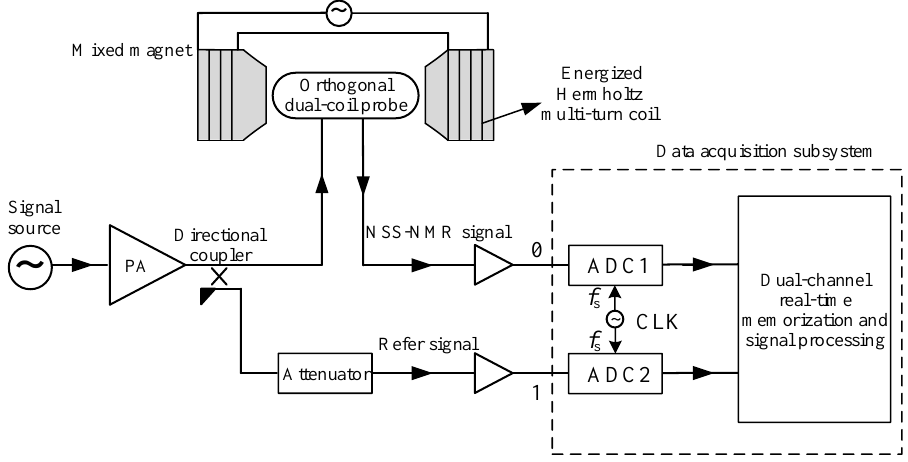
Figure 4. An NSS − NMR experimental system based on a mixed magnet, an orthogonal dual-coil probe and data acquisition subsystem.